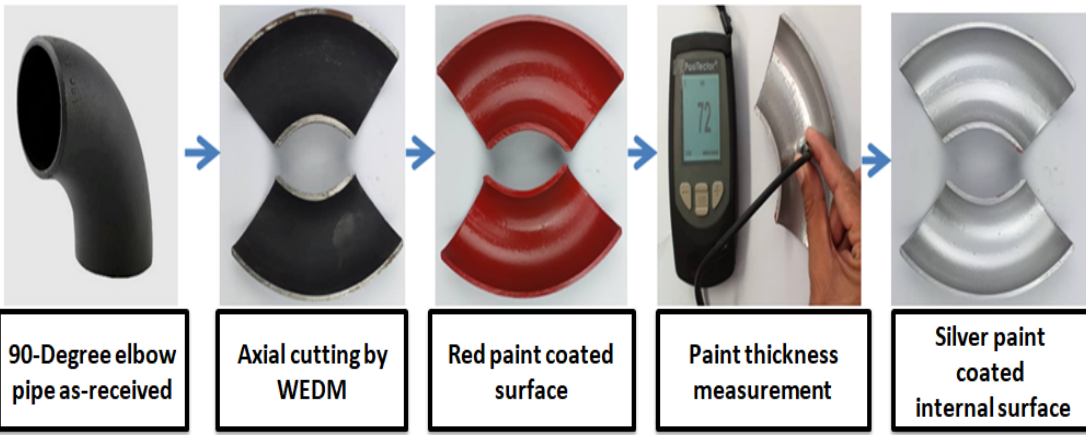
Figure 3. Multilayer paint modeling (MPM) sample preparation stages.